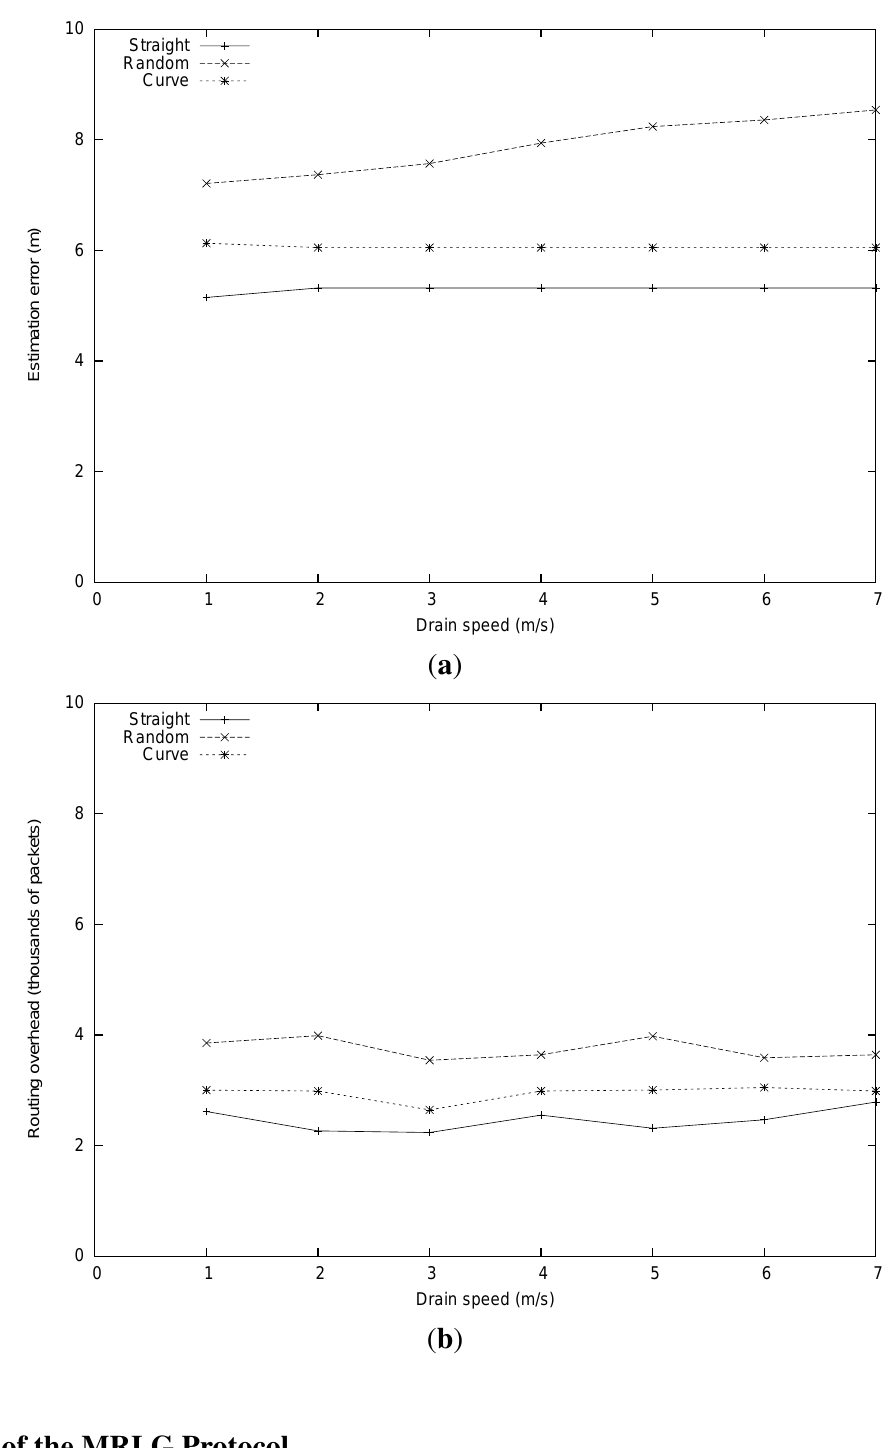
Figure 4. For different mobility patterns when varying the sink speed: ( a ) mean position estimation error, ( b ) routing